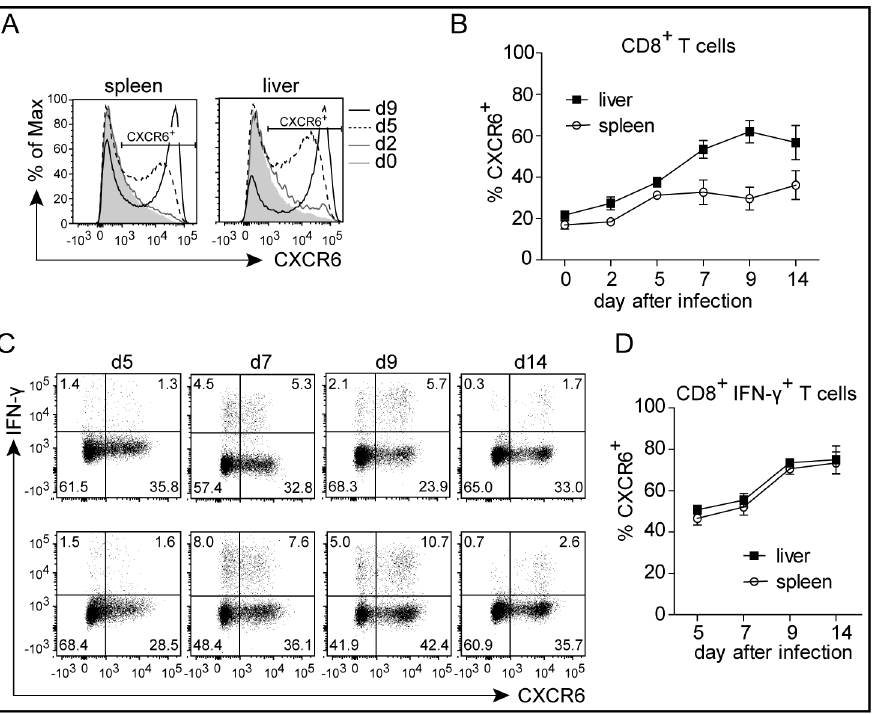
Figure 1. CXCR6 expression on CD8 + T cells during L.monocytogenes infection. CXCR6 + /GFP mice were infected with 1 6 10 4 Lm OVA i.v. and cells from spleens and livers were analyzed at indicated time points. (A) Representative histogram of CXCR6 expression by CD8 + T cells. (B) Expression of CXCR6 by CD8 + T cells. (C) Representative dot plots of CXCR6 and IFN– c expression by CD8 + T cells. Upper row: spleen, lower row: liver (D) Expression of CXCR6 by IFN– c + listeria-specific CD8 + T cells. Symbols in (B) and (D) give the mean 6 SEM, n $ 5 and are representative for two